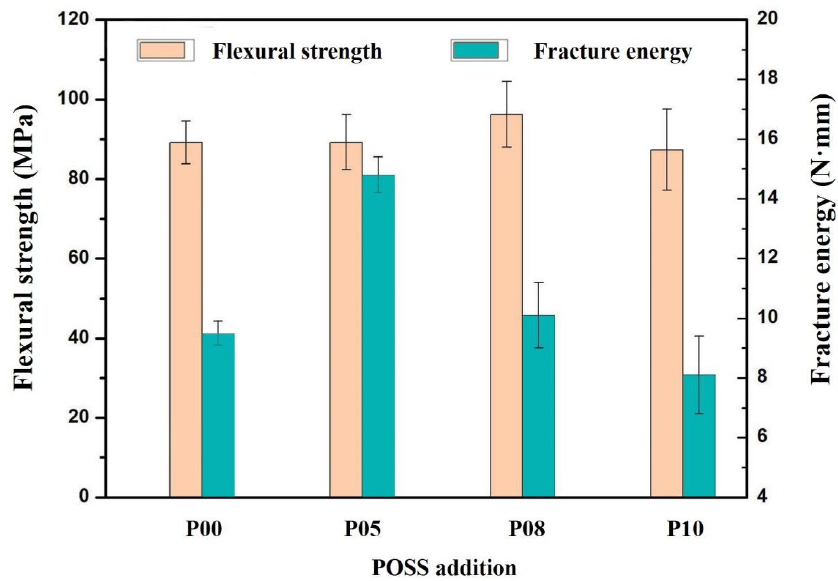
Figure 6. Flexural strength and fracture energy of composite resins with different POSS additions.